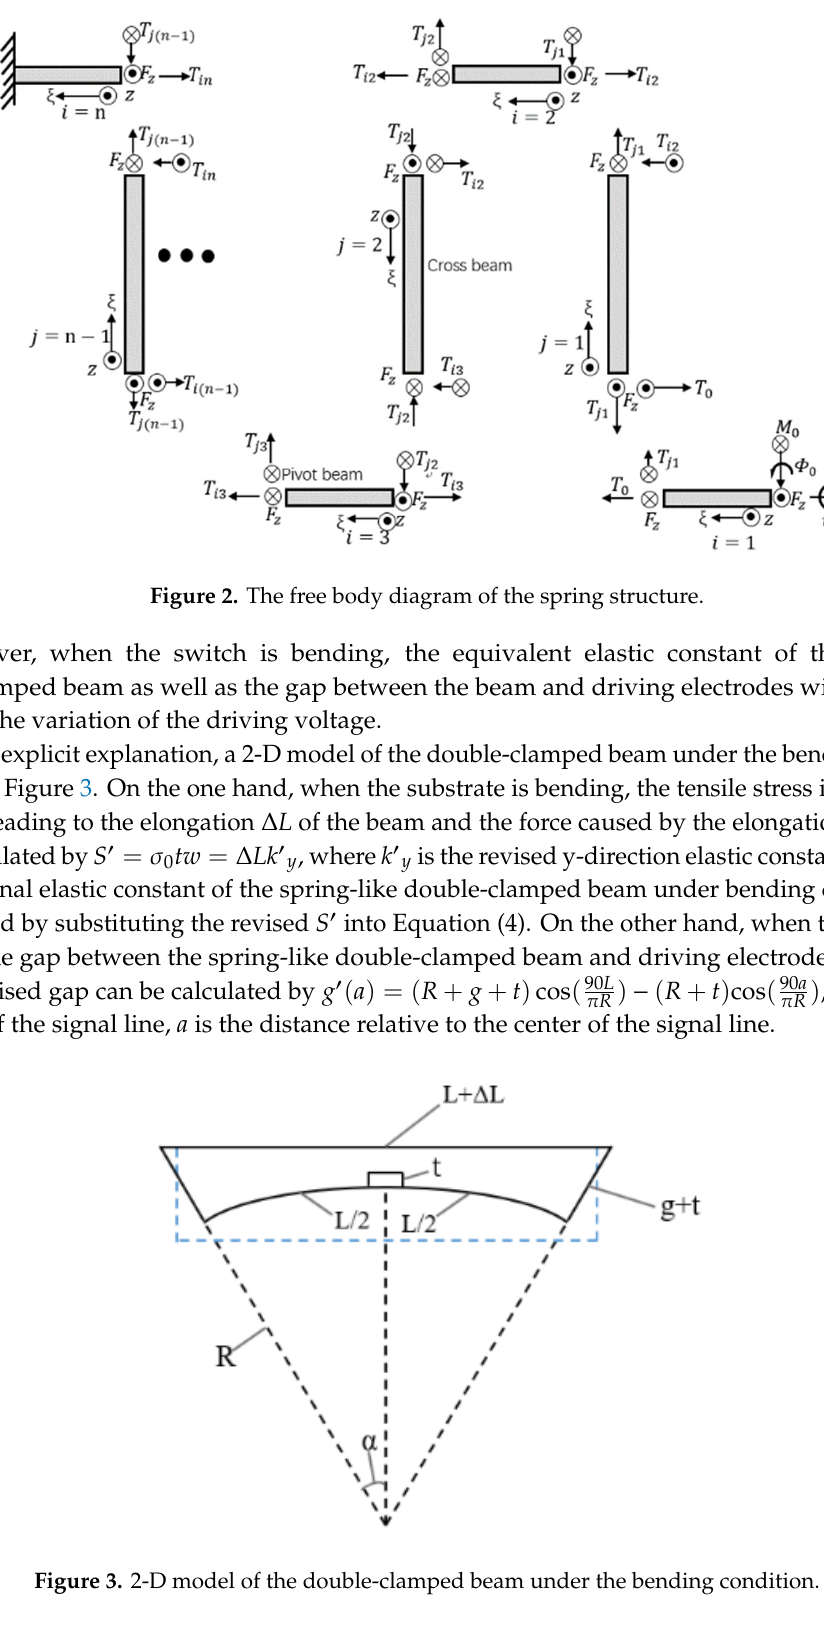
Figure 2. The free body diagram of the spring structure.